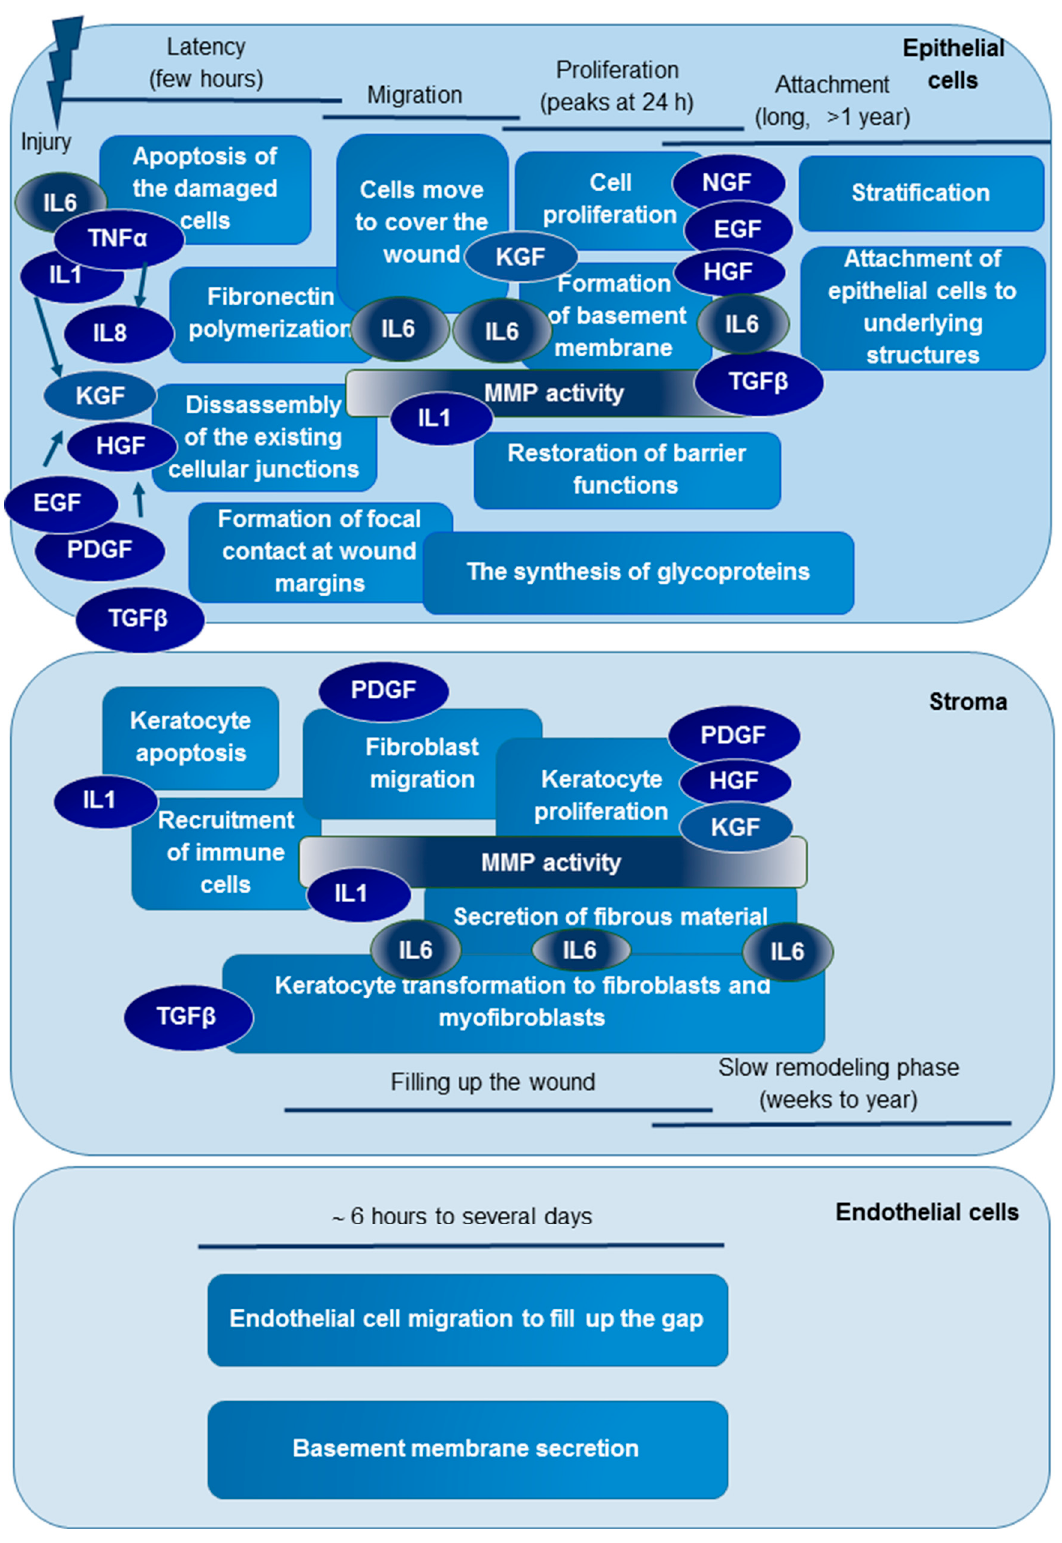
Figure 5. Phases of ocular wound healing. The events that are characteristic for the different phases of ocular wound healing and the regulator molecules are marked with rectangles with ovals, respectively. The dark blue cytokines and growth factors were examined in this study, and those with the black color were found to show statistically significant changes. Following injury in the first few hours in the lag or latency phase, the released cytokines (mainly IL- 6 1, IL-6, TNF- α , and IL-8) orchestrate the early events of epithelial wound healing. The damaged cells are 7